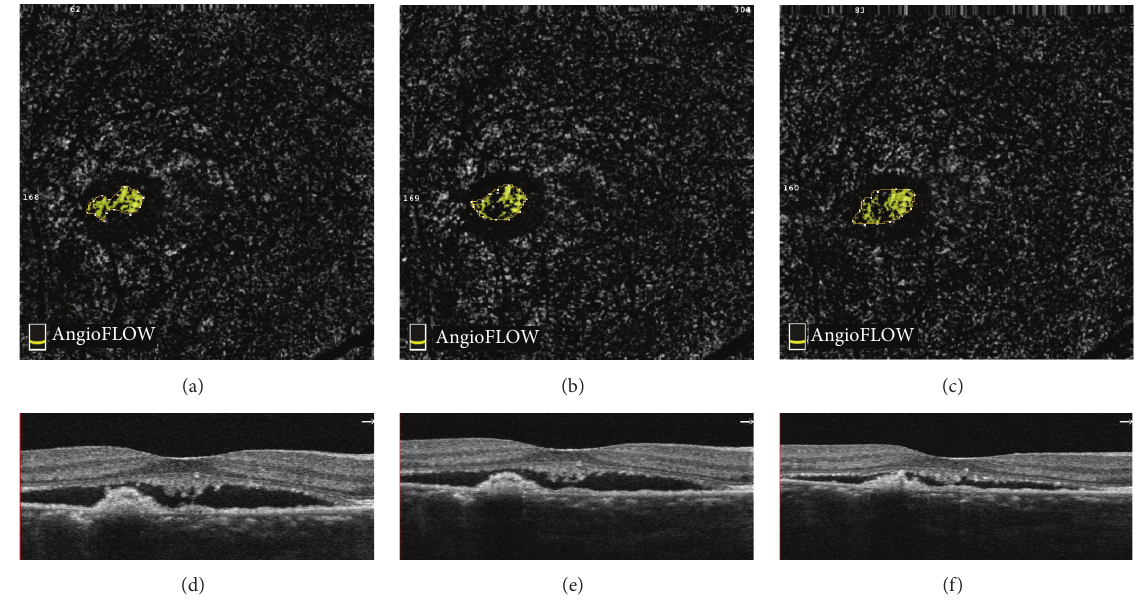
Figure 4: OCTA images with associated B-cans of a female patient. ((a)–(c)) CNVs form before treatment, 1 day after treatment, and 1 month after treatment on OCTA. The selected CNV areas were 0.089 mm 2 , 0.097 mm 2 , and 0.116 mm 2 . The flow areas were 0.048 mm 2 , 0.045 mm 2 , and 0.060 mm 2 . ((d)–(f)) B-scans of 3 detections. The CRT was 367 𝜇 m, 354 𝜇 m, and 287 𝜇 m. The subretinal fluids were decreased